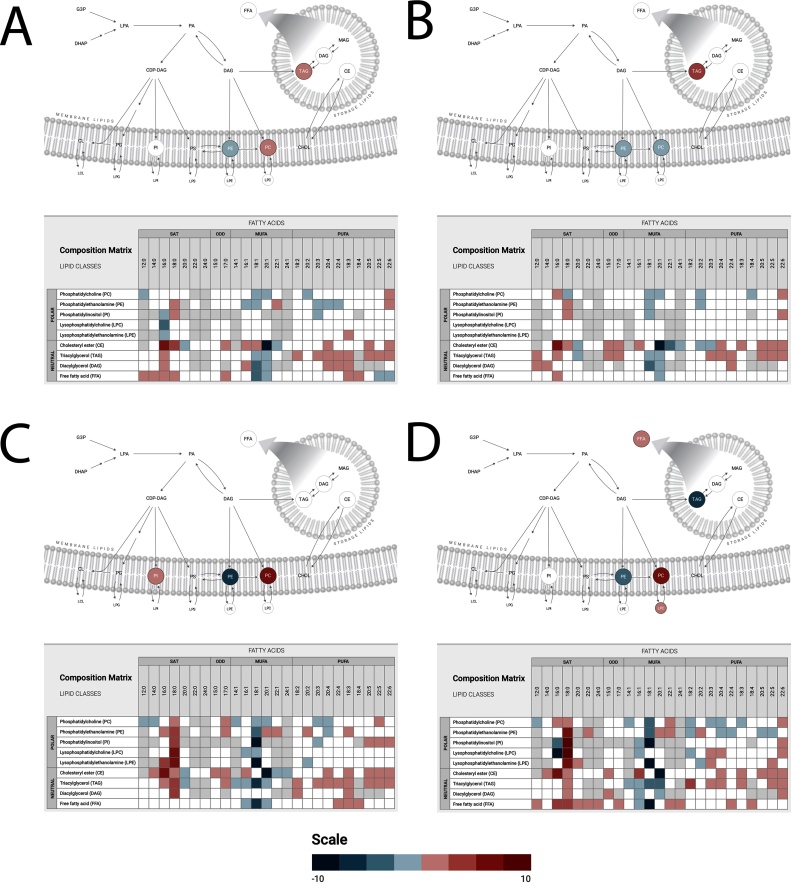
Complex lipid pathway maps in Atlantic salmon hepatocytes exposed to A) 100 μM chlorpyrifos-methyl, B) 100 μM pirimiphos-methyl, C) 100 μM nonylphenol and D) a combination of 100 μM of all three compounds (generated with Metabolon’s Surveyor tool). Significance levels are based on mole percent data, mean differences and log-transformed P-values (p < 0.05).